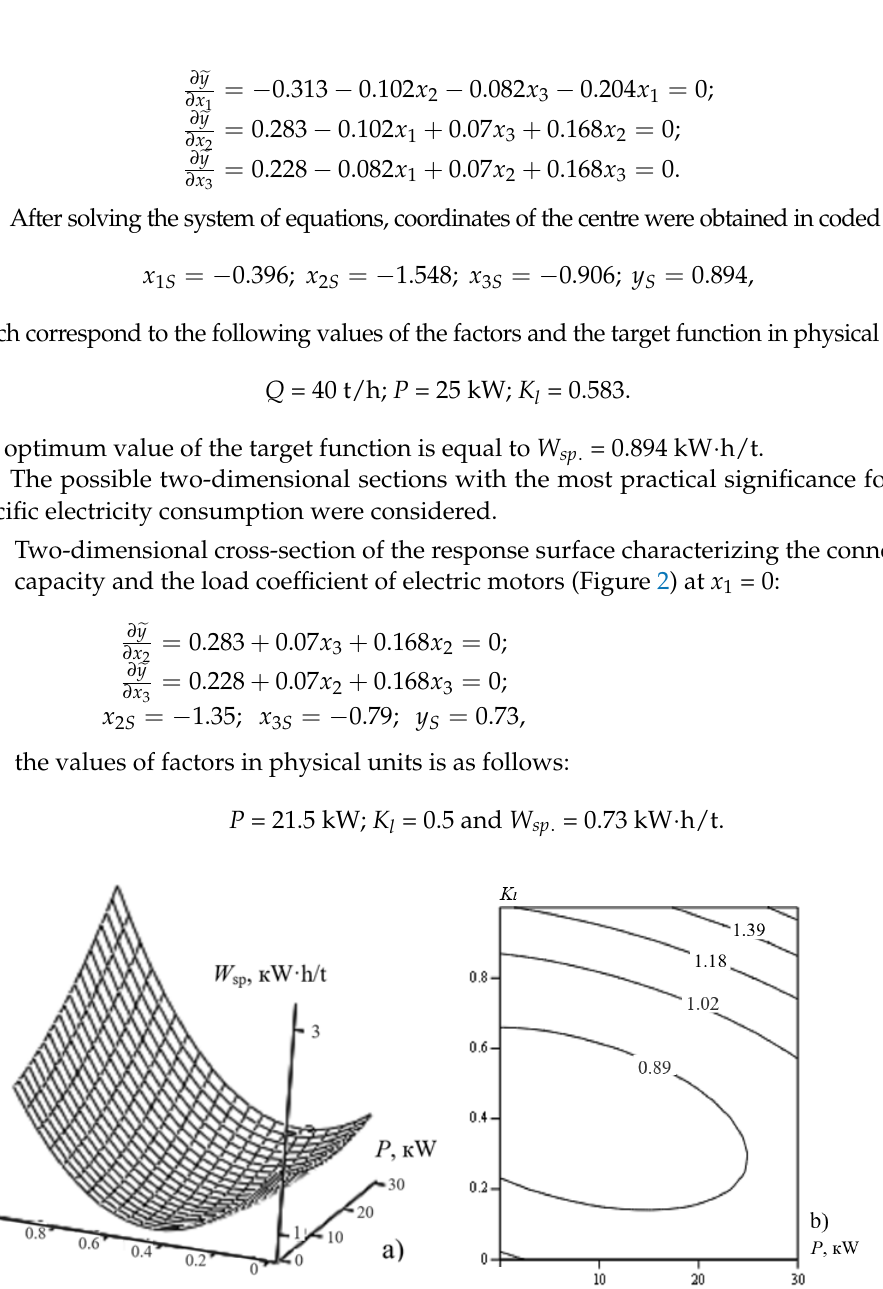
Figure 2. Response surface of the target function ( a ) and its two-dimensional cross-sections ( b ) for ZAV-40 at x 1 = 0.